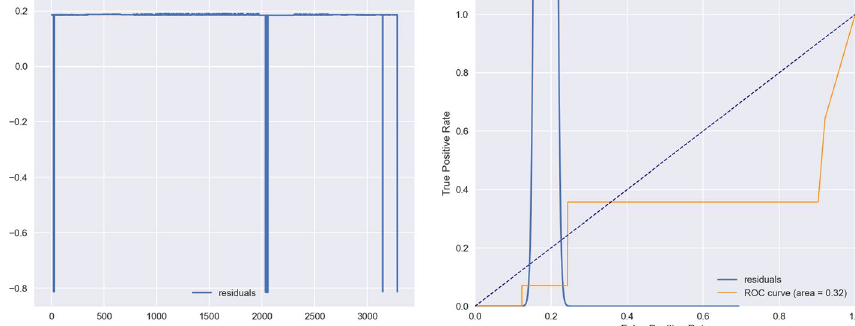
Fig. 3 Results of applying XGBoost to D21 only. Left: residual sequence with original timed order. Right: ROC curve and residual distribution